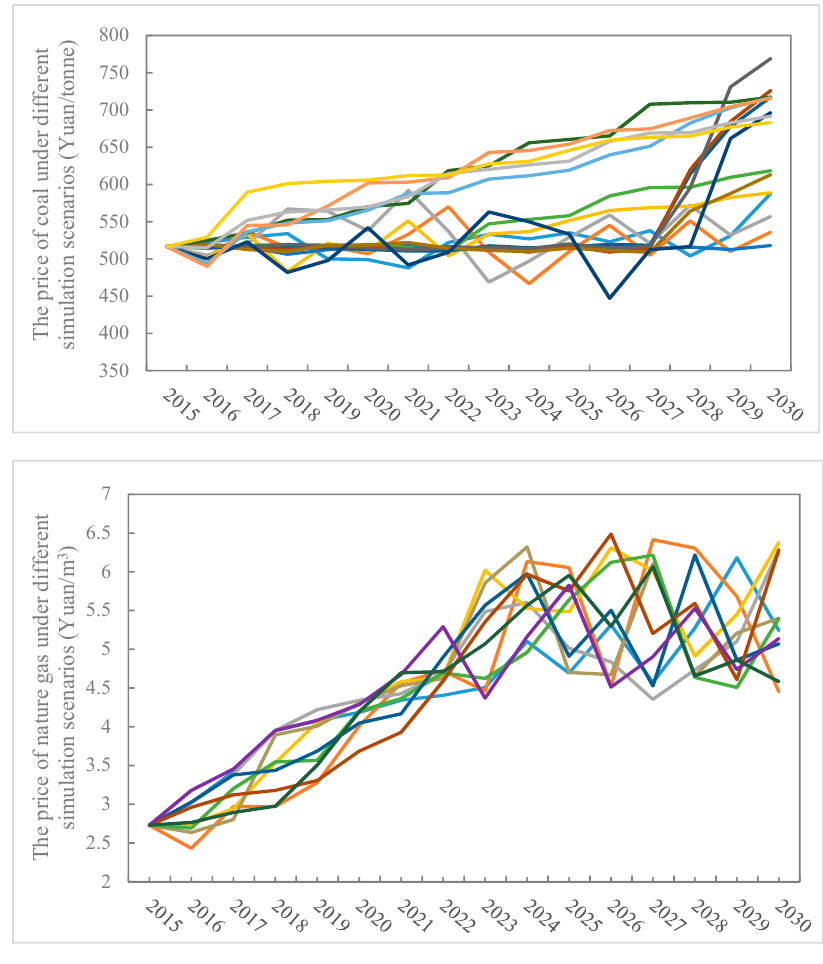
Figure 4. The prediction price of the fuel under 16 scenarios from 2015~2030.